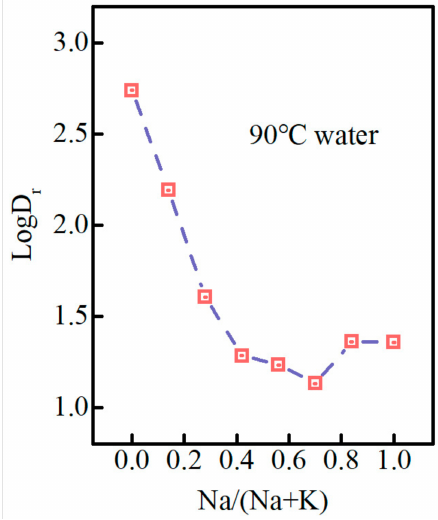
Figure 3. Dissolution rate curve of the PKNi glass with different Na/(Na+K) ratios in a 90 ◦ C water bath for 48 h. Table 2. Dissolution rate and ion release concentration in solution of PKNi glass with different Na/(Na+K)